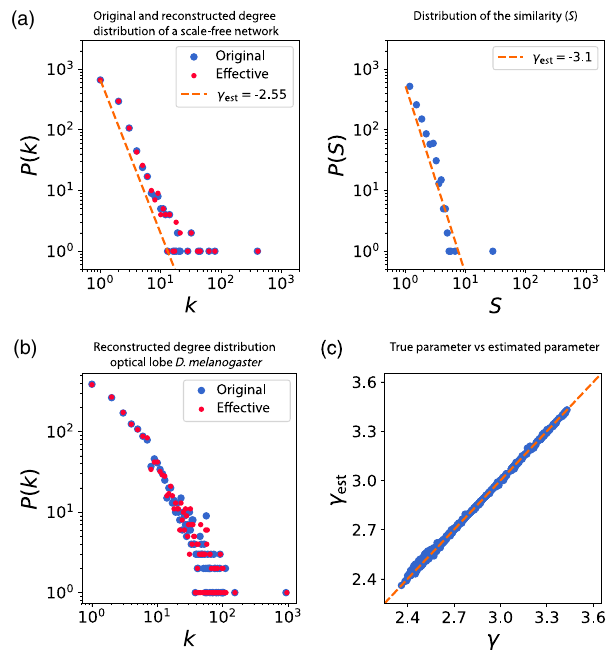
FIG. 5. Reconstruction of structural power-law exponents γ of scale-free networks from data. We estimated γ from the multi- variate time series obtained from the dynamics random scale-free networks with degree distribution P ð k Þ ∝ k − γ . The plots in (a) compare the functional and effective network approach. We obtain better estimates using the effective network. Panel (b) shows the degree distribution of the original system (in blue) and that estimated from an effective model (in red) for the neural network in the optical lobe of Drosophila melanogaster . We obtained an accuracy of 3% in the structural exponent γ . Panel (c) shows the true exponent γ versus γ obtained with an est effective network from data for spiking neuron coupled with chemical synapses. We generated 1000 networks with distinct γ , from which the γ estimate is within 2% est